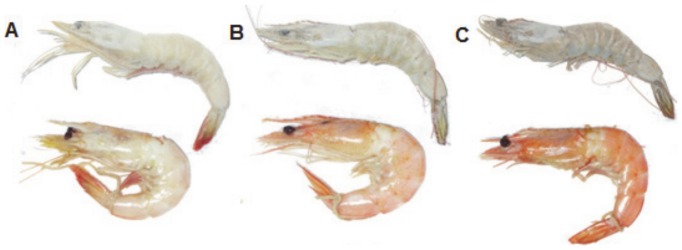
Example of cooked albino (a), light (b) and dark (c) F. merguiensis used in this study.Albino (a), light (b) and dark (c) prawns in the top row are uncooked, with a photo of the same animal after cooking directly below for comparison.